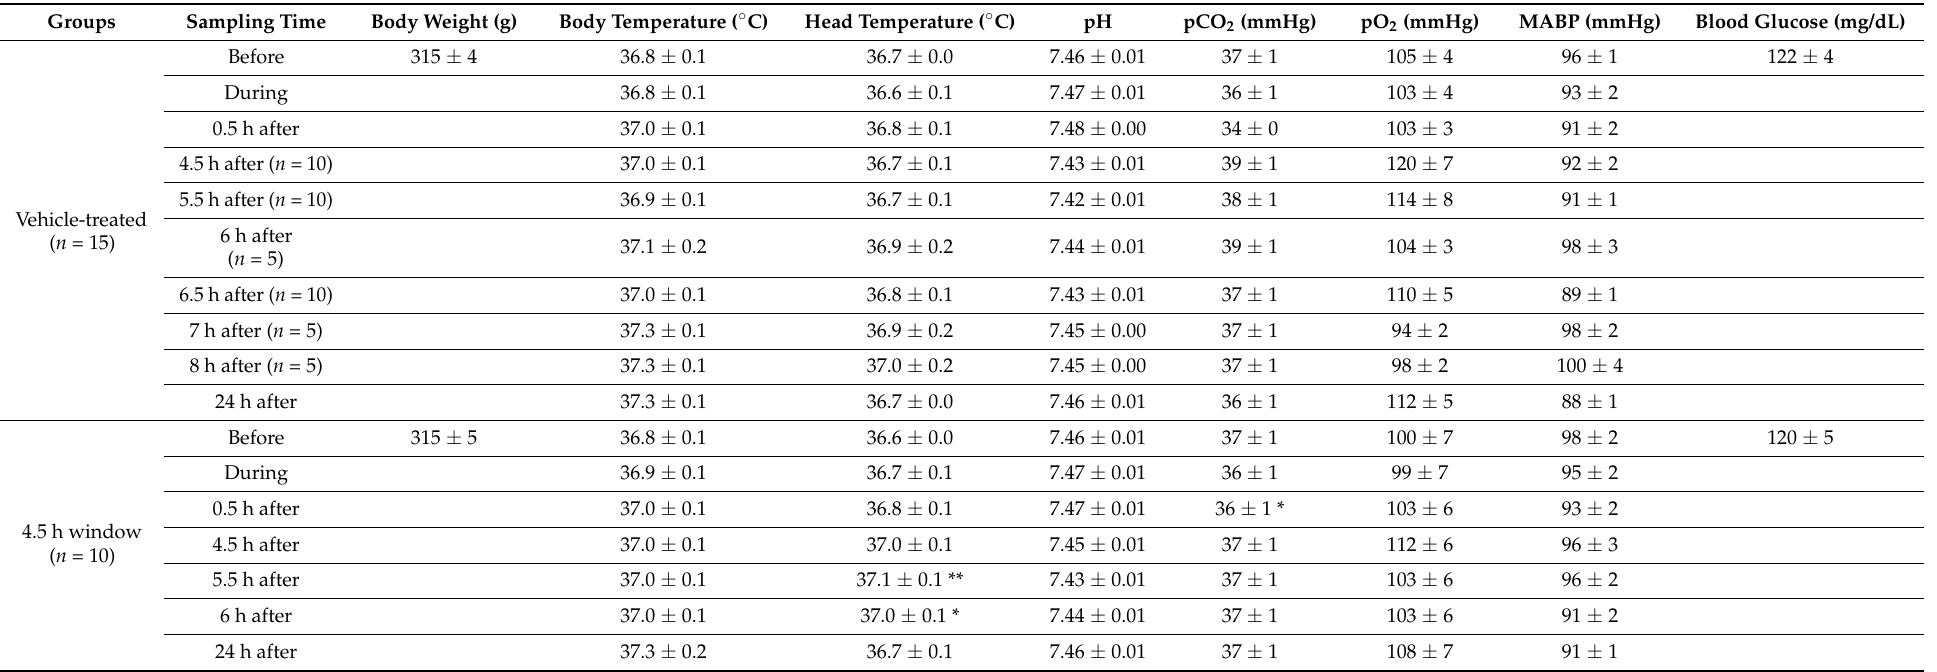
Table 3. Physiological parameters before, during, and after collagenase injection and during vehicle/RMP treatment in male rats employed in the therapeutic window